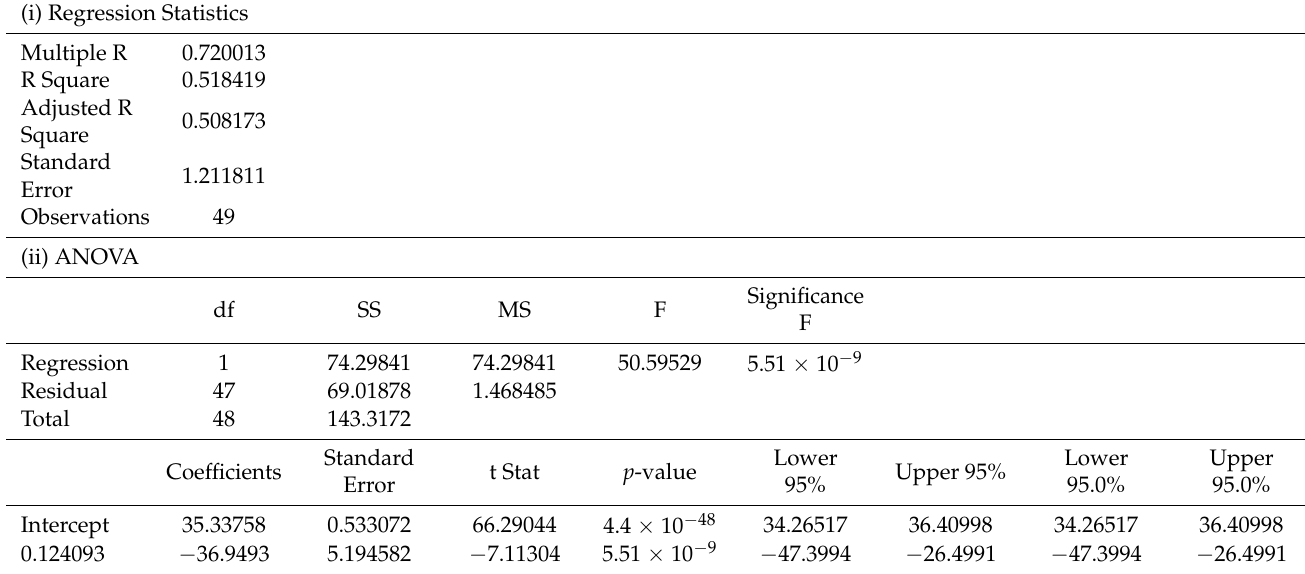
Table A5. Regression Statistics between LST and NDVI for 2020.